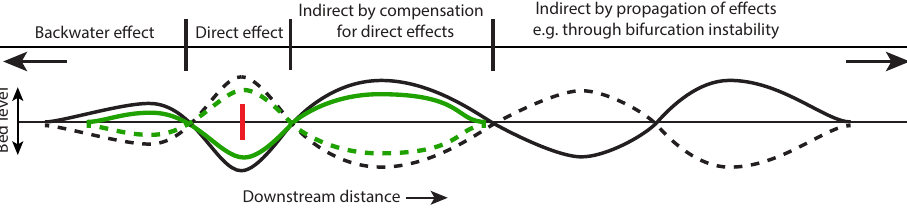
Figure 17. Regions of morphological response to a disturbance (red line): (1) direct effects such as local incision due to flow confinement (solid lines) or local deposition after sand mining (dotted lines), (2) indirect by compensation for the direct effects and thus deposition downstream of flow confinement or incision downstream of sand mining, (3) indirect by propagation of effects through bifurcation instability and asymmetrical reshaping of bars, and (4) upstream by backwater